Question: According to the figure, is the described quantity increasing or decreasing?
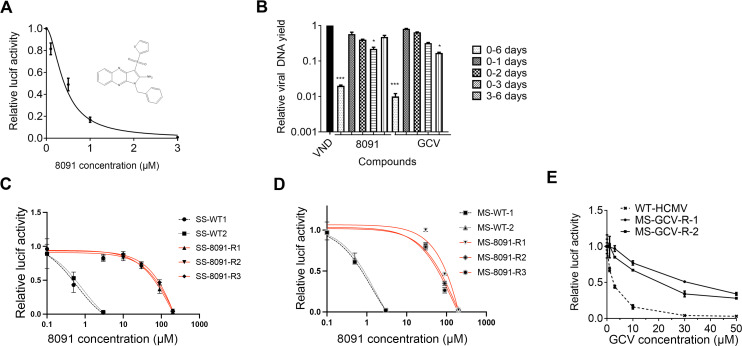
Answer: increasing